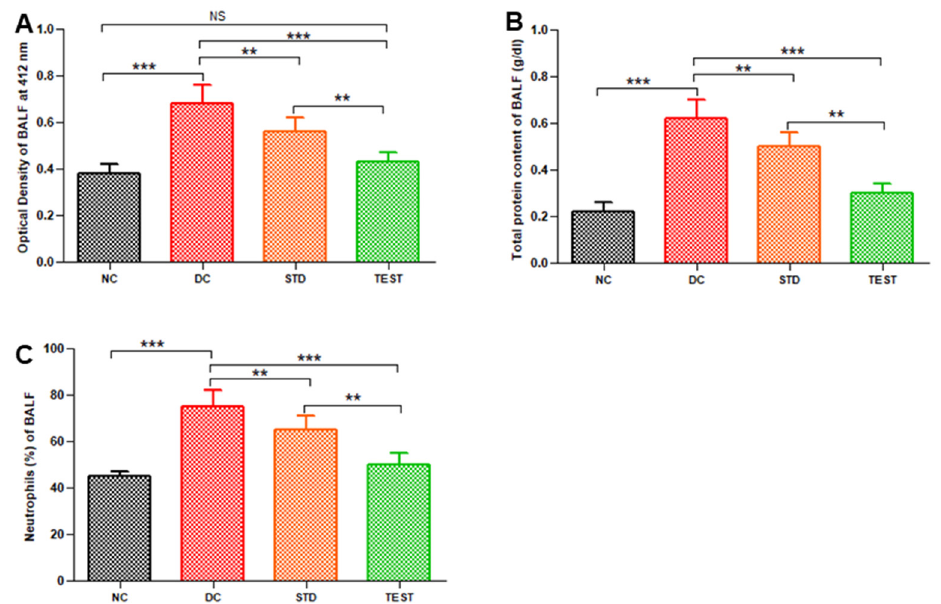
Figure 4. Pulmonary haemorrhage in terms of optical density of BALF ( A ), total protein ( B ), and neutrophil ( C ) in BALF from various groups namely, Normal Control (NC), Disease Control (DC), standard treatment of conventional dexamethasone injection (STD), and test formulation treatment with dexamethasone microspheres (TEST) ( n = 6). ** and *** represent significant differences at p < 0.01 and p < 0.001, respectively, by Newman–Keuls analysis following ANOVA at 95% confidence limit. NS = Non-significant.